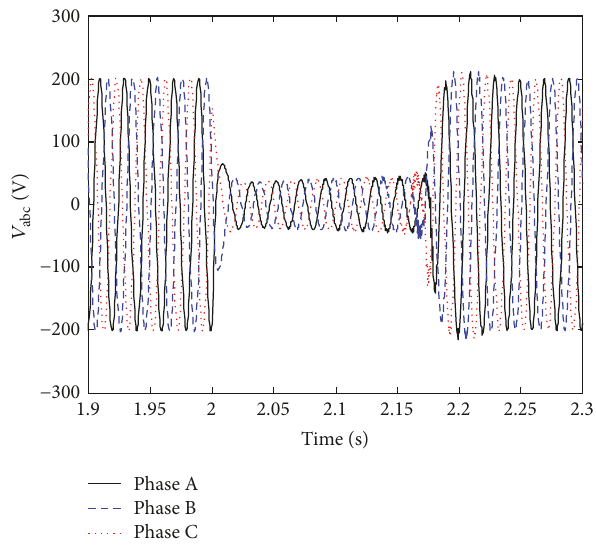
Figure 13: Three-phase voltage characteristics of the wind genera- tion system under the symmetrical fault.